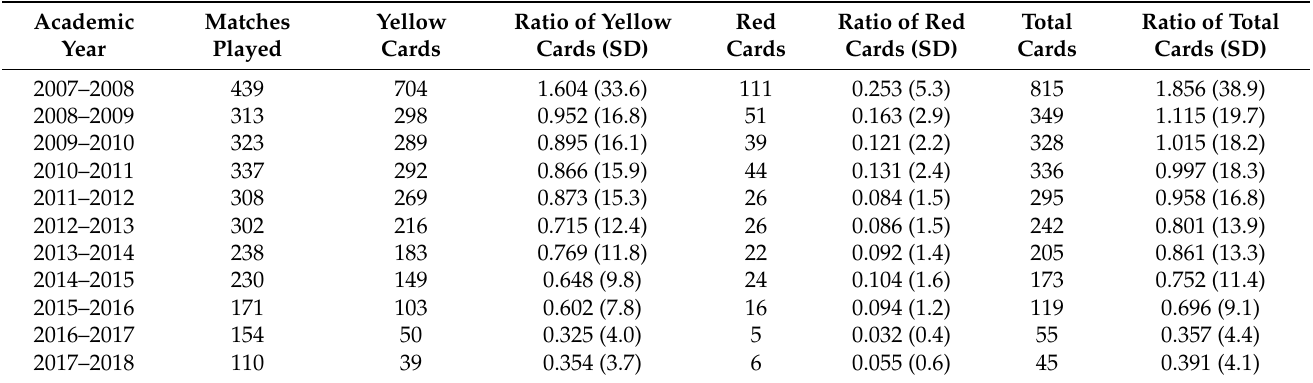
Table 5. Evolution of the ratios of cards shown in the ten academic years analyzed, and ratios concerning the previous season.